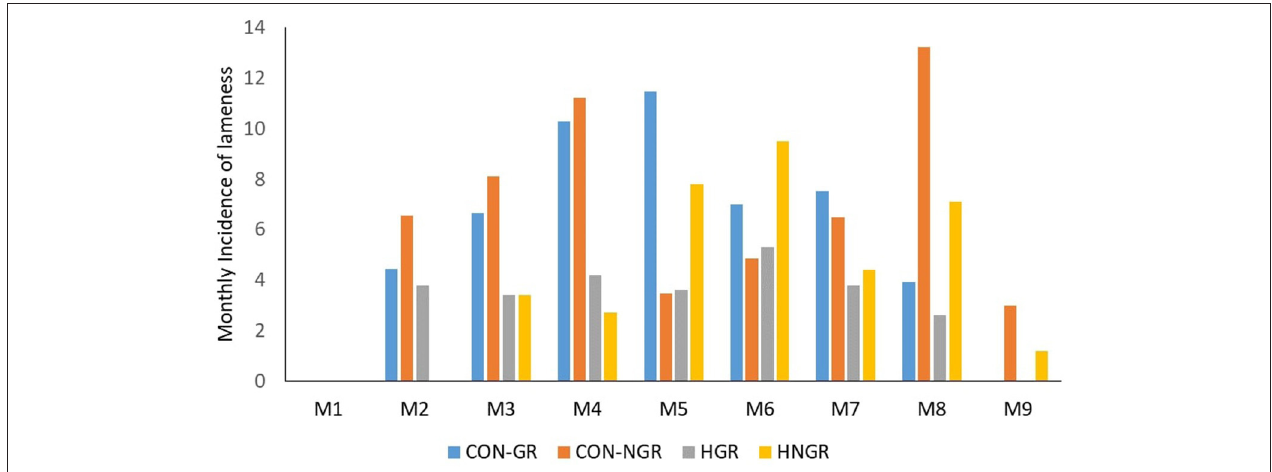
FIGURE 1 | Incidence rate of lameness in hoof-trimmed and control cows in non-grazing and grazing herds during the 9 month study period (M1 = first month post-enrollment, M9 = ninth month post-enrollment).